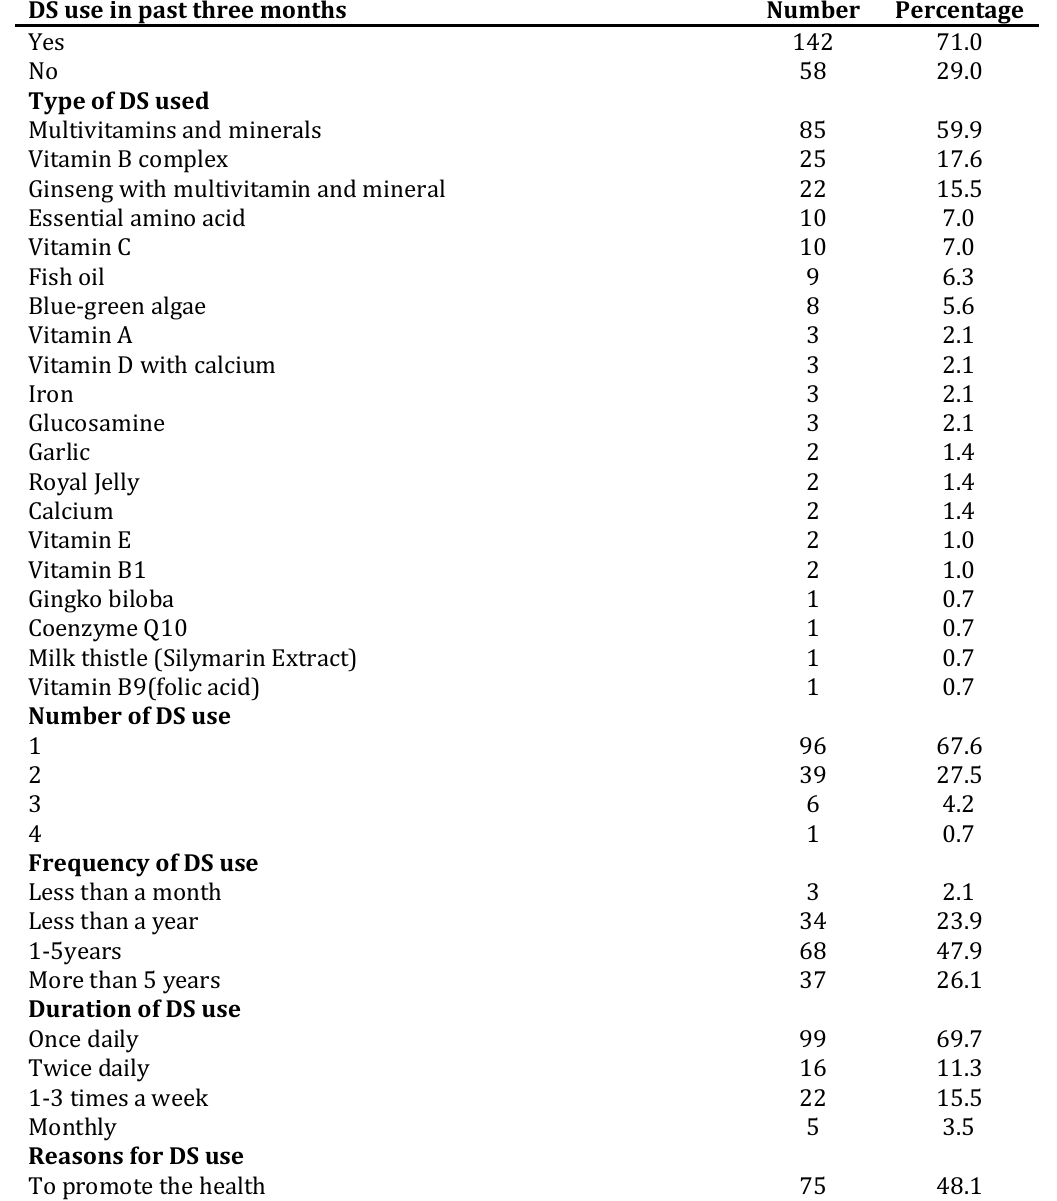
Table 3: The use of